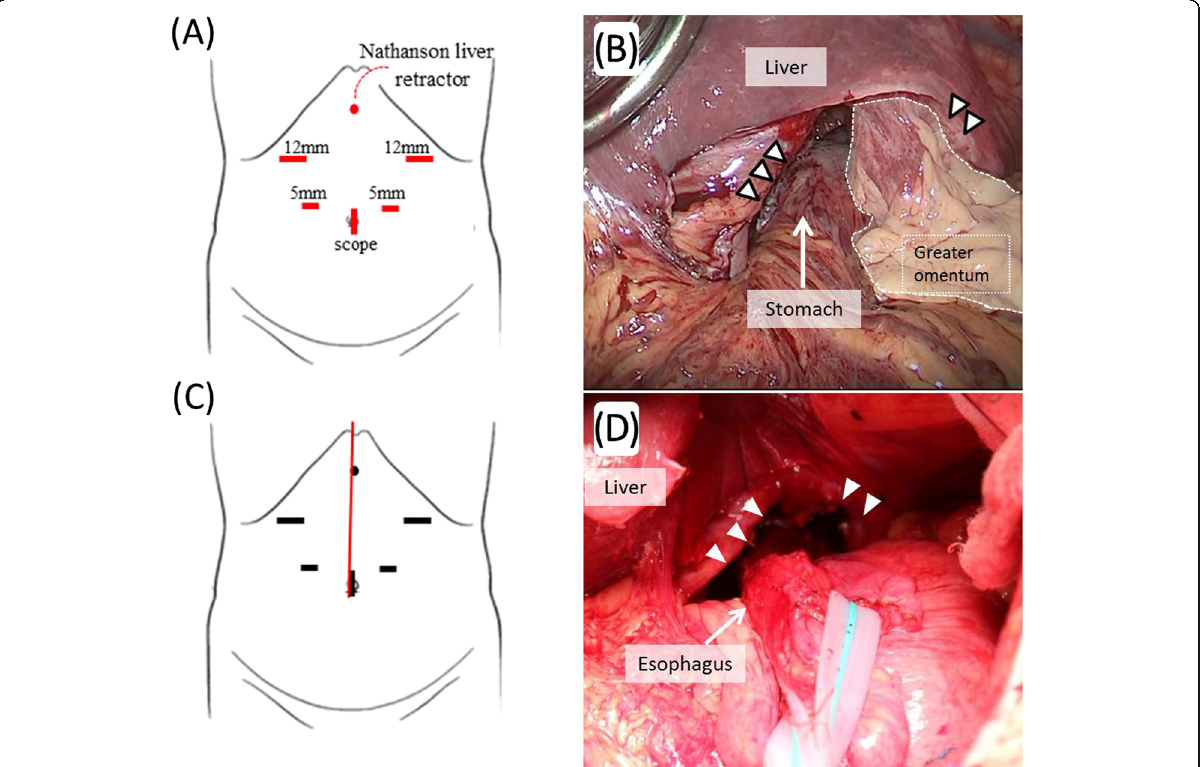
Fig. 4 Port setting for hernia repair and operative findings. In total, five ports and Nathanson liver retractor were placed in the abdomen ( a ). A loose adhesion was observed just under the operative scar in the abdominal cavity; in contrast, the adhesion in the hernial sac was stronger. The esophageal hiatus was dilated to 7 cm in diameter (arrow heads). The hiatal hernia was identified and found to contain the entire postoperative stomach ( b ). We converted laparoscopic surgery to open surgery, and upper midline abdominal incision was added ( c , red line). After